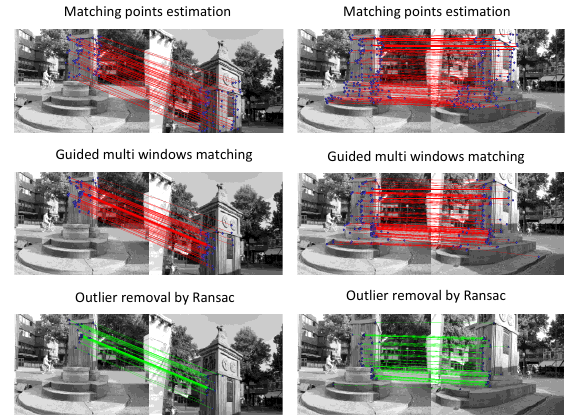
Figure 8. The wrong correspondences extracted by VSfM due to symmetrical or repetitive texture and pattern.